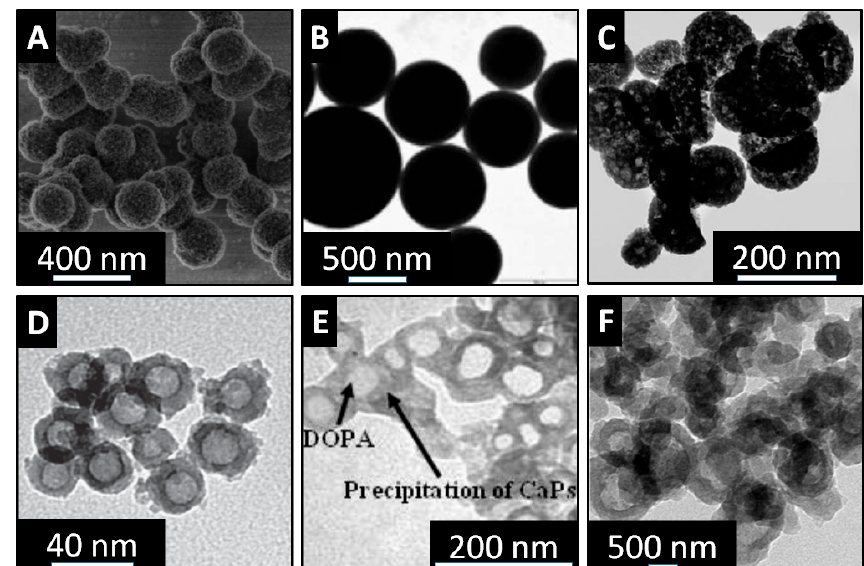
Figure 7. ( A ) SEM image of amorphous calcium phosphate particles synthesized by using CaCl 2 ·2H 2 O as the calcium source and ATP as both the phosphorous source and stabilizer by microwave-assisted hydrothermal method at 120 °C for 10 min. Reproduced with permission from [168]. Wiley Publishing Groups, 2013; ( B ) TEM images of calcium phosphate precipitates. Reproduced with permission from